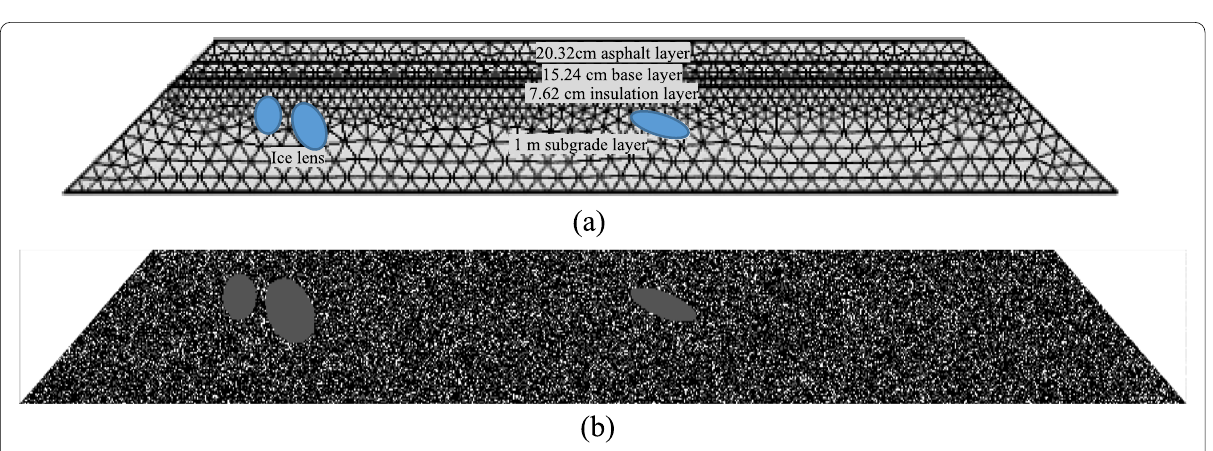
Fig. 7 a Mesh of the pavement structure; b Phase coded model in subgrade